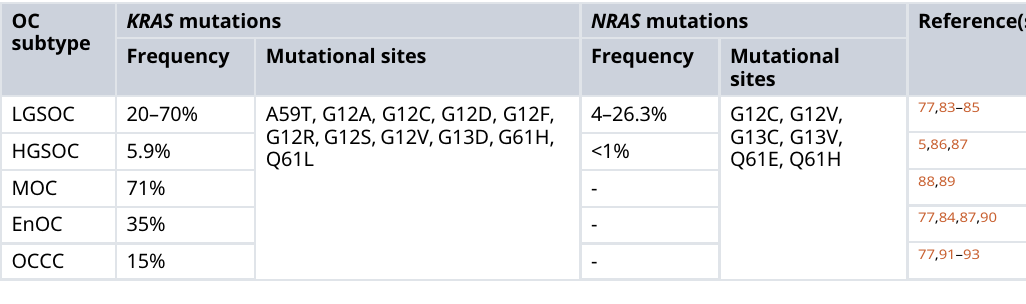
Table 1. Frequency of incidence of KRAS and NRAS mutations in different subtypes of OC.